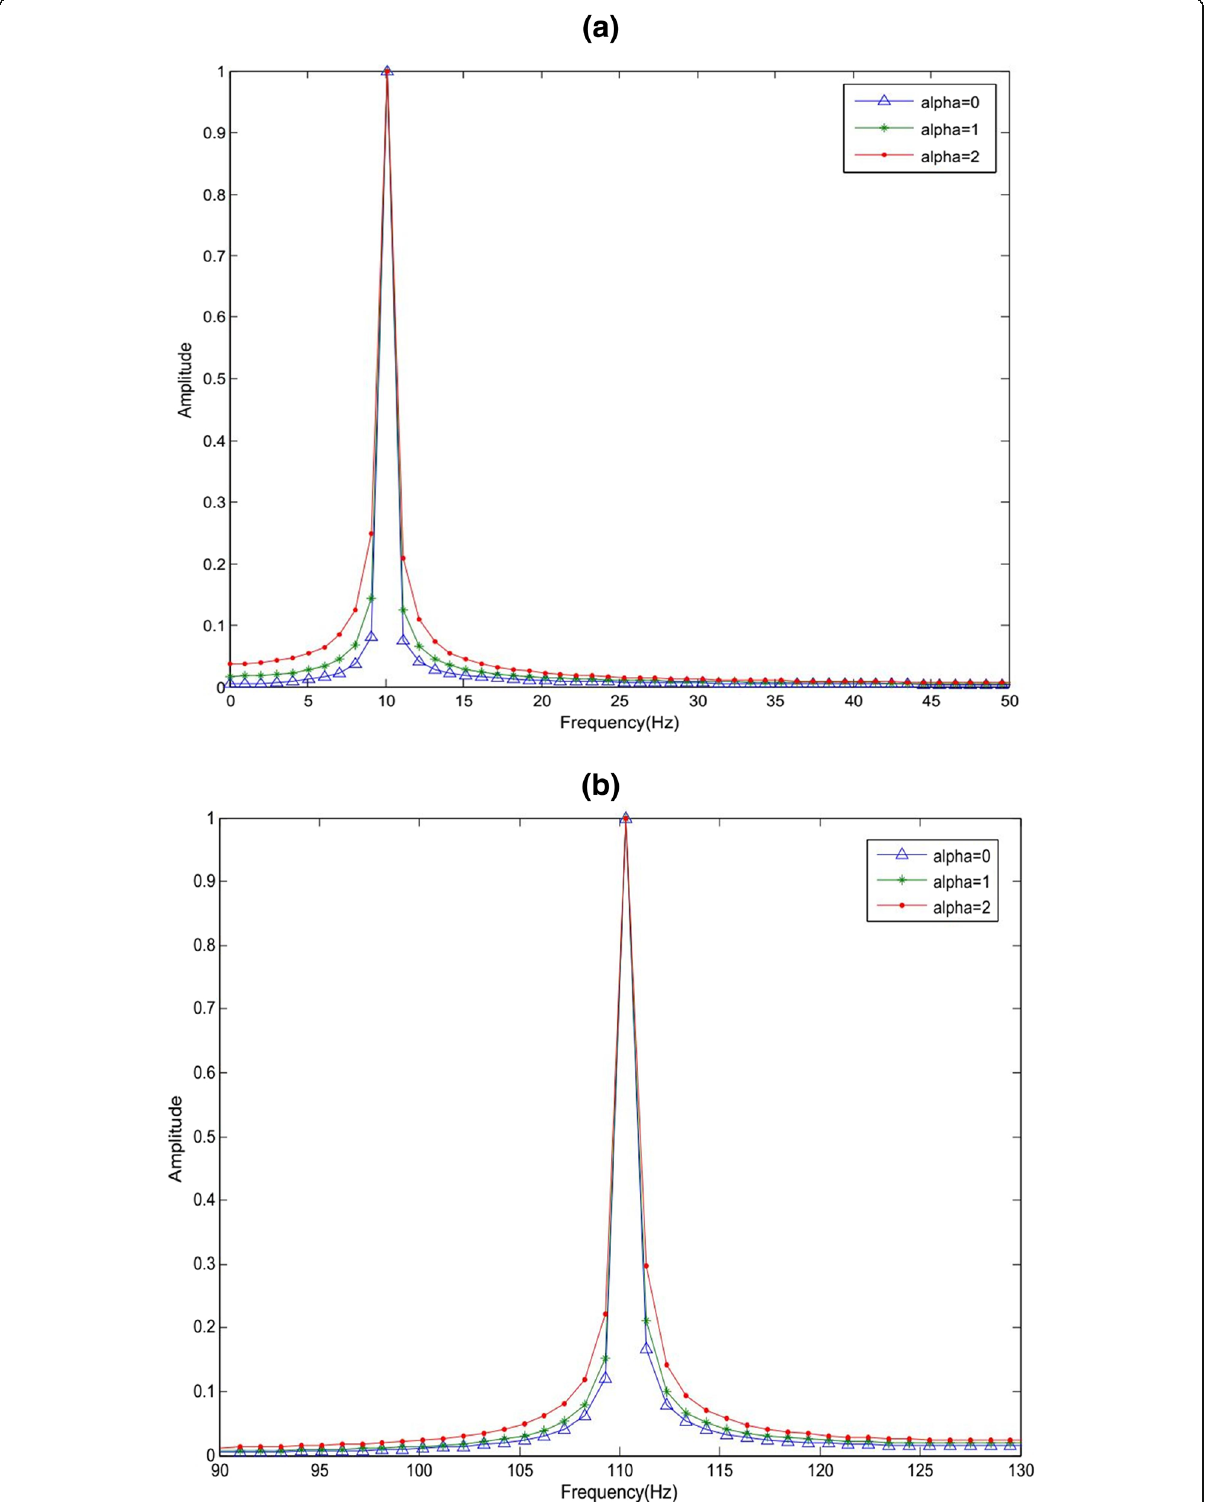
Fig. 5 Characteristic curves of the MEFMs under different parameters in frequency domain. a In lower-orders moments. b In higher-orders